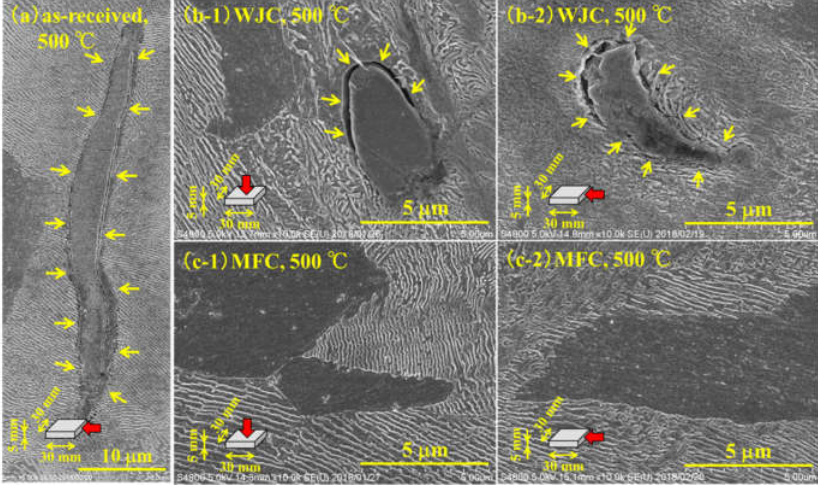
Figure 7. SEM images of the Cr–Mo steel (SCM 435) surface heated at 500 ° C for 5 h.